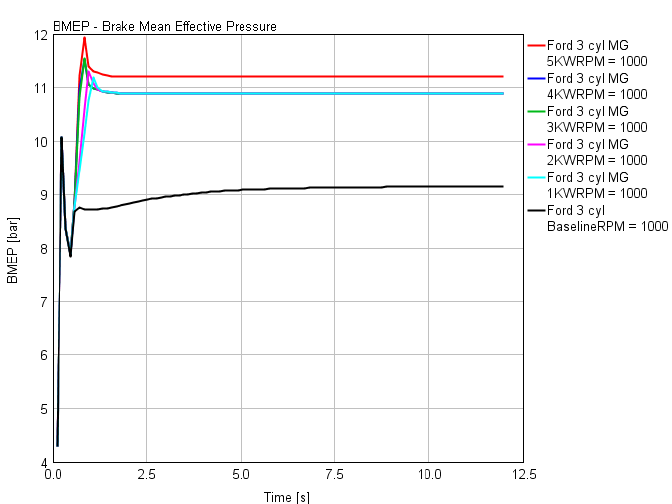
Figure 11. Brake Mean Effective Pressure (BMEP) response time at 1000 rpm engine speed.